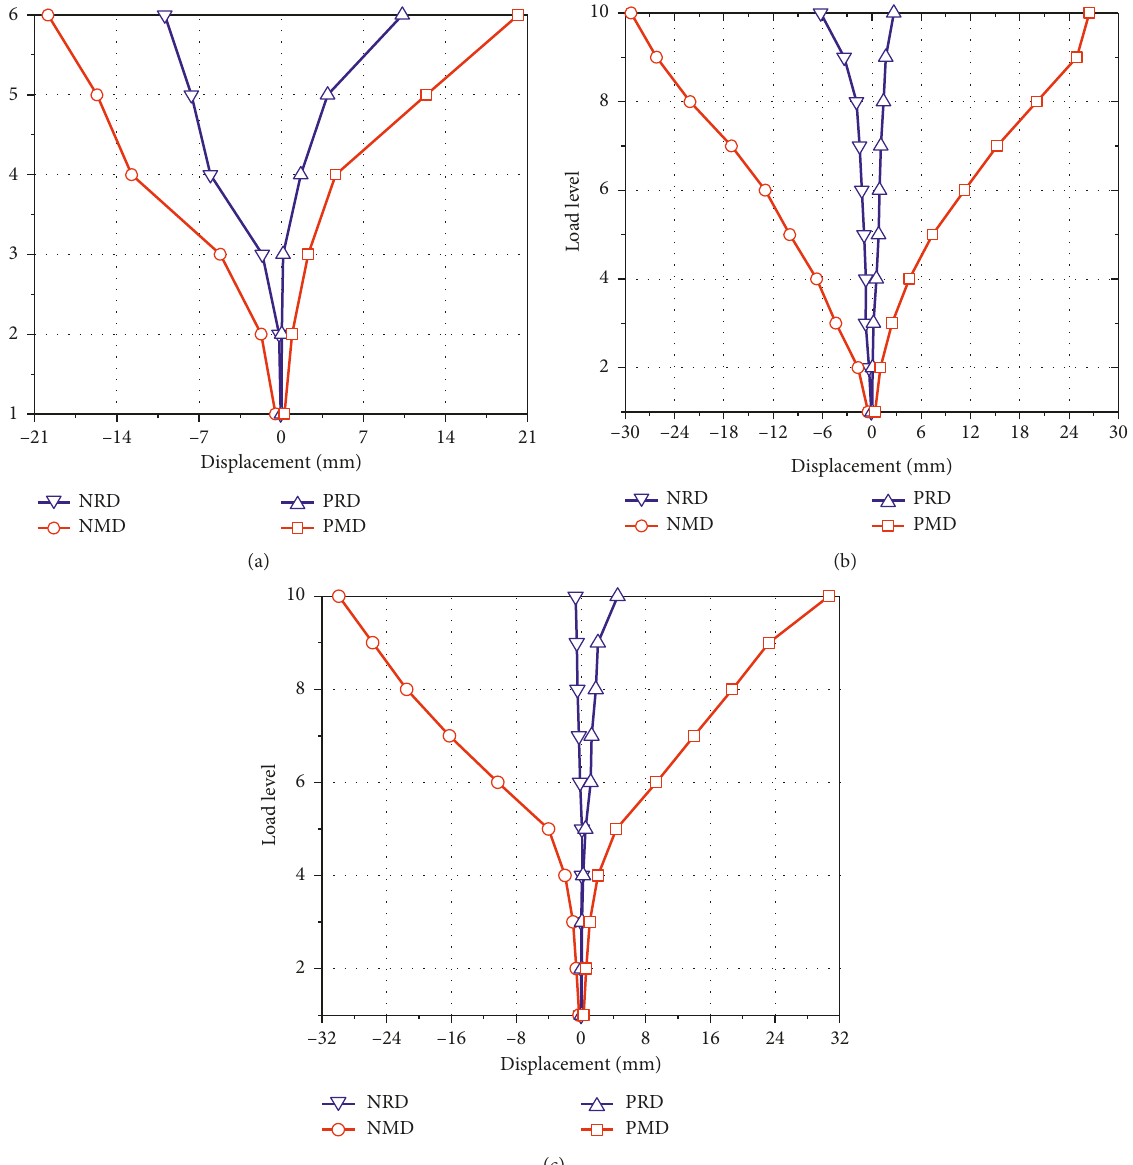
Figure 16: Comparison of residual and maximum displacements (NRD: negative residual displacement; NMD: negative maximum displacement; PRD: positive residual displacement; PMD: positive maximum displacement): (a) SW1, (b) SW2, and (c)